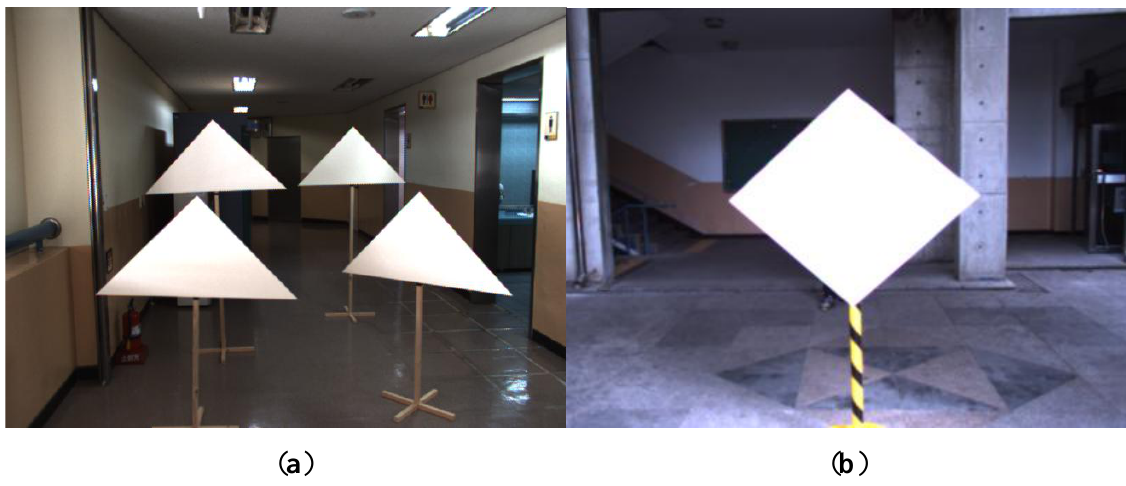
Figure 4. Polygonal planar boards: ( a ) Triangle board and ( b ) Diamond